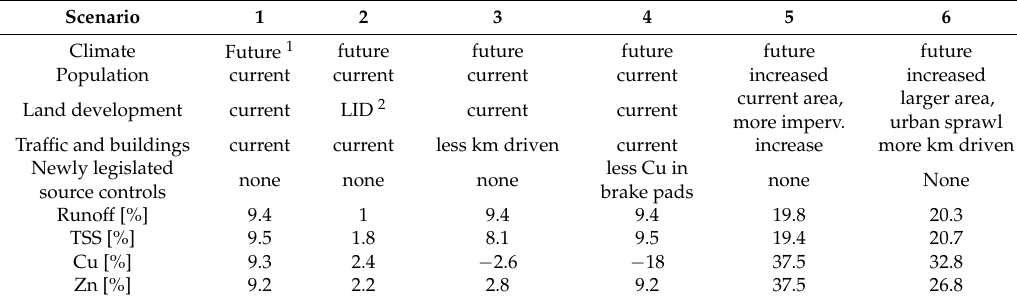
1 More rainfall, higher rainfall intensities; 2 LID = Low Impact